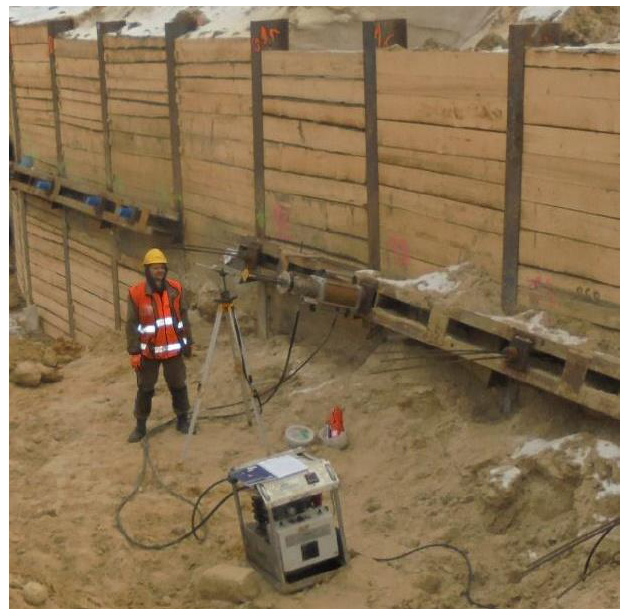
Figure 8. Details of excavation protection: load test of ground anchors.